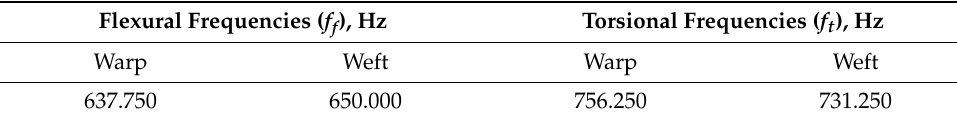
Table 4. Flexural ( f f ) and Torsional frequencies ( f t ).